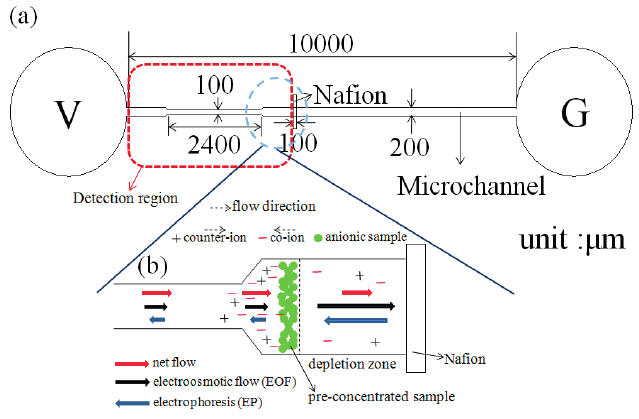
Figure 1. Schematic illustrations of ( a ) Nano-microfluidic chips with a convergent microchannel and ( b ) The flow field, charges and pre-concentrated sample distribution along the